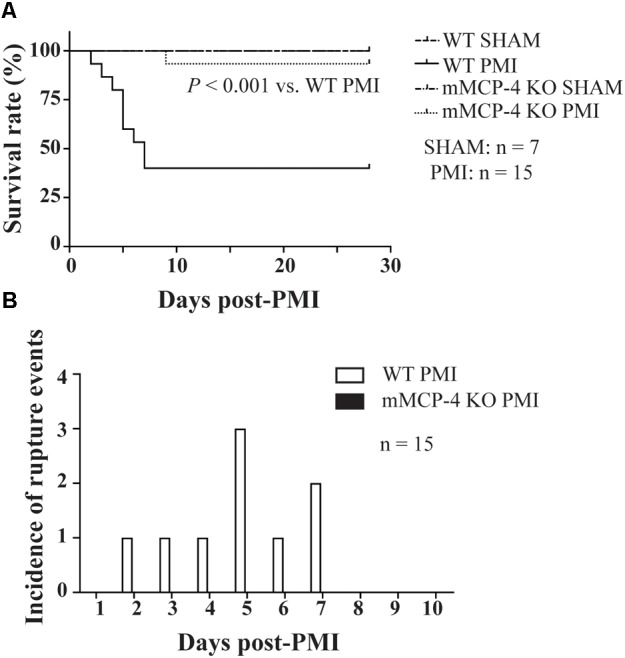
Kaplan-Meier 28-day survival analysis of mouse survival (Mantel-Cox test) (A) and incidence of left ventricular free wall rupture events (B) following LAD coronary artery ligation (A). PMI: n = 15, SHAM: n = 7.